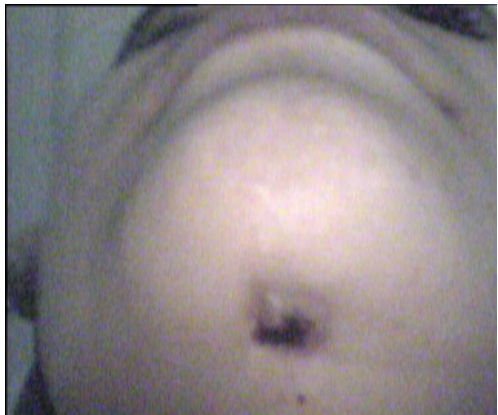
Figure(7): 21 years old female with extra oral sinus due to infected cyst associated with necrotic lower central incisor (pre operative picture), (group